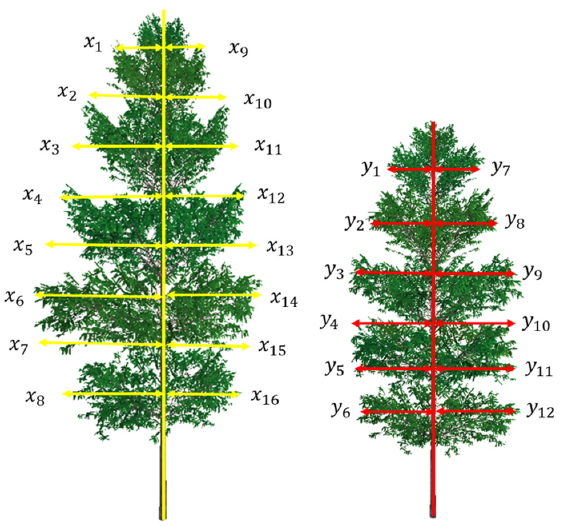
Figure 3. Description of canopy shape and evaluation of fit. The x and y represent the distance from the canopy edge to the trunk; the arrows with two directions are used to identify this distance.